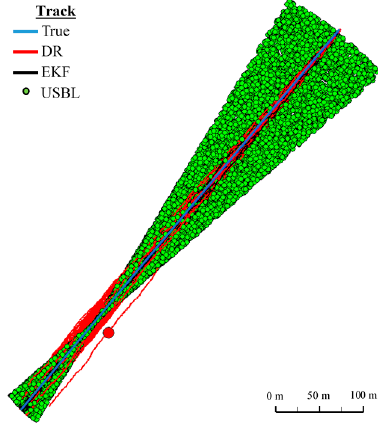
Figure 19. Determined routes (one hundred passages).